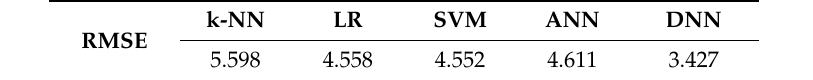
Table 5. Models created from the training dataset. Algorithm Model Description 22-Nearest Neighbor model for regression k-NN The model contains 624 examples with seven